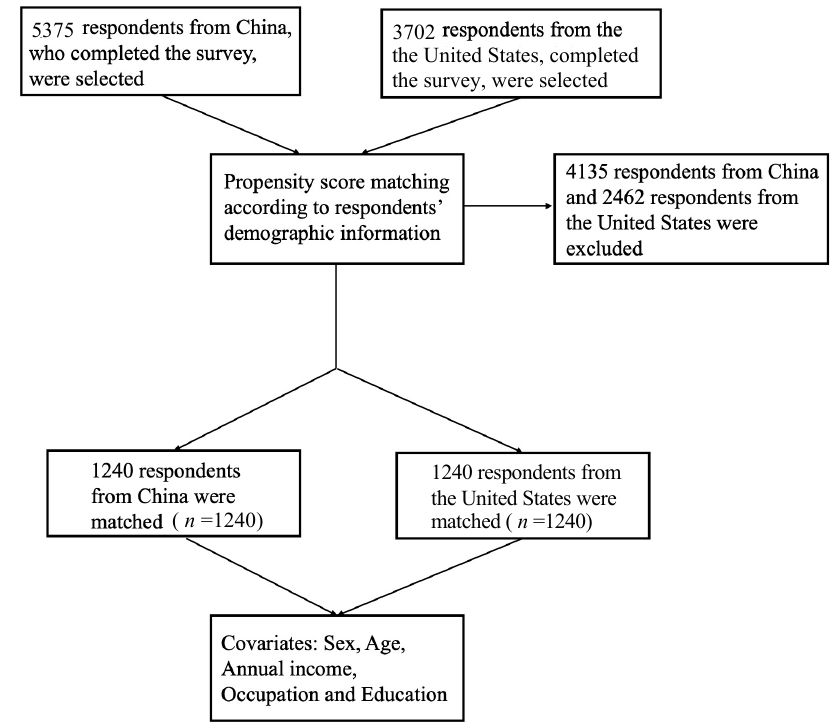
Figure 1. The flow chart of propensity score matching.